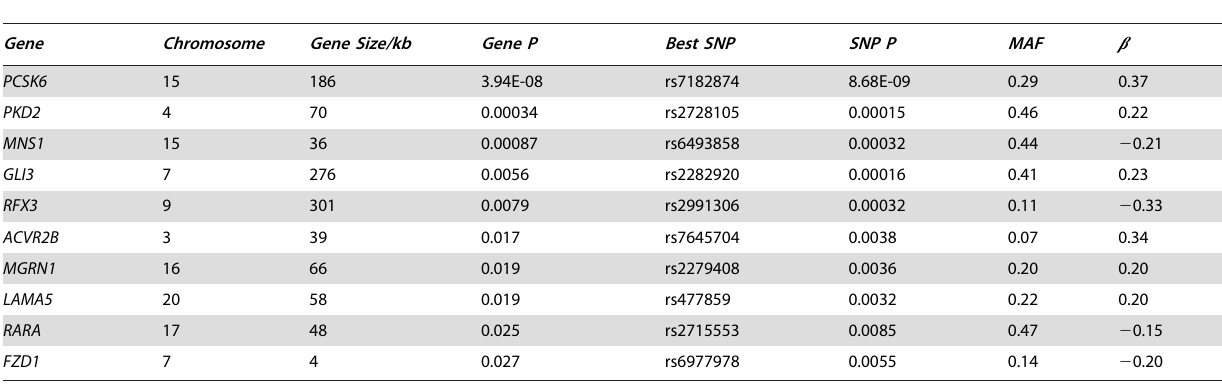
Table 5. LR asymmetry genes are associated with relative hand skill (meta-analysis of cohorts 1–3).